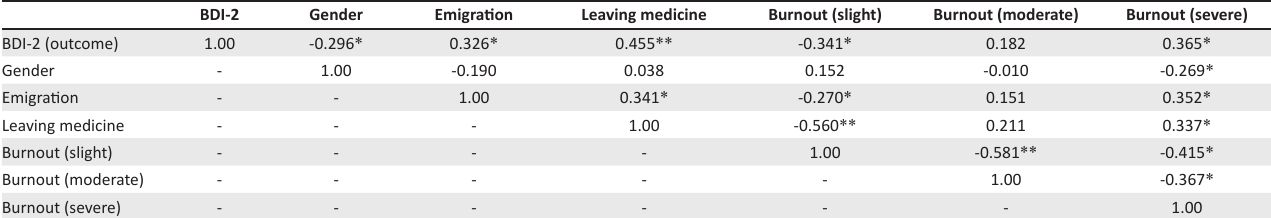
TABLE 3: Correlations between outcome and predictor variables. BDI-2